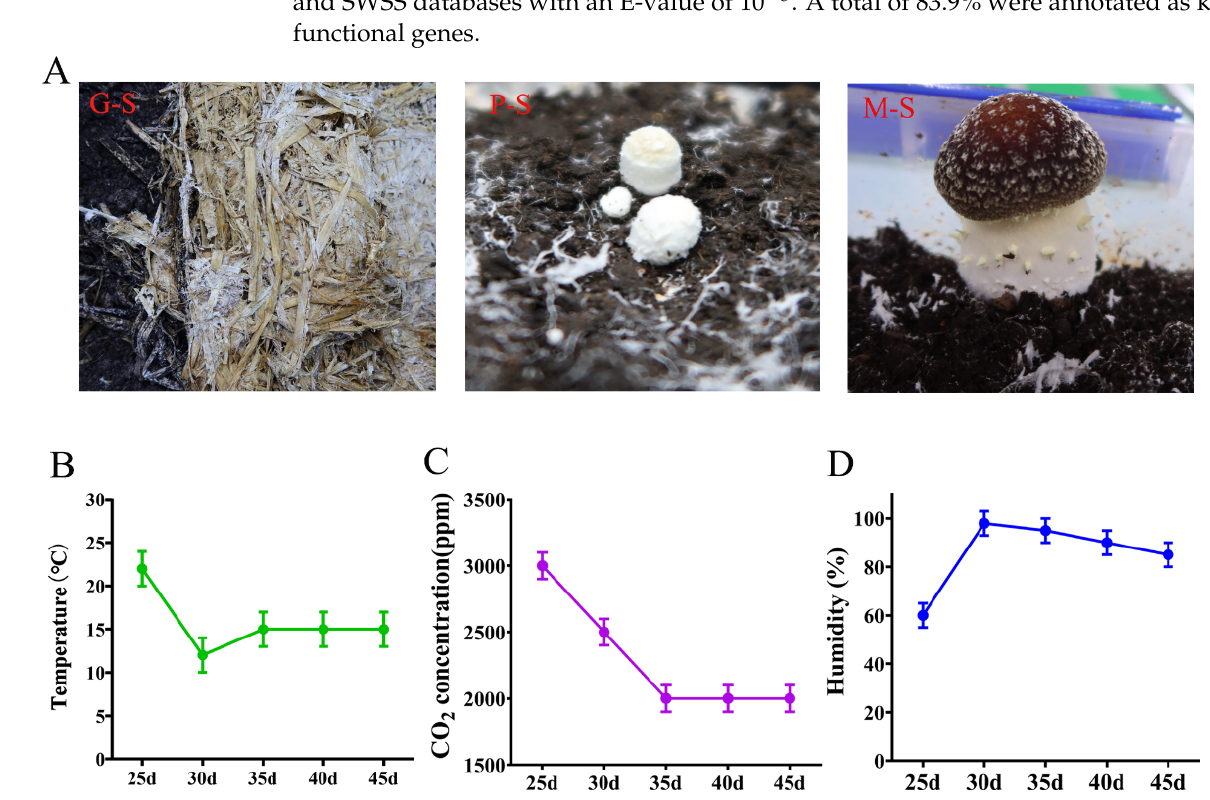
Figure 1. Different growth and development stages of S. rugosoannulata under industrialized condi- tions. ( A ) Different developmental stages of S. rugosoannulata —G-S: hyphal growth stage; P-S: primordium stage; M-F: mature fruiting body stage. ( B ) Temperature changes during growth and development. ( C ) Changes in carbon dioxide concentration during growth and development. ( D ) Hu- midity changes during growth and development.